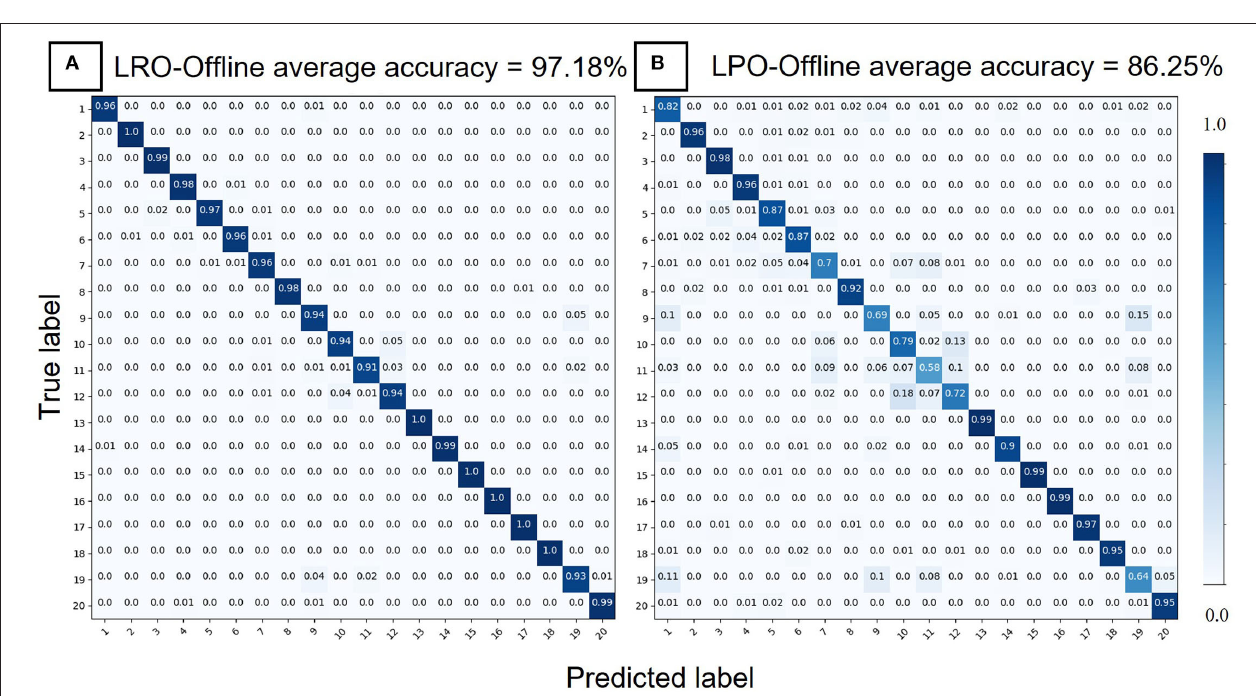
FIGURE 7 | Confusion matrices for the data of the 20 general gesture dictionary. (A) Result of the Leave-recording out (LRO) scheme. (B) Result of the Leave-person out (LPO) scheme.